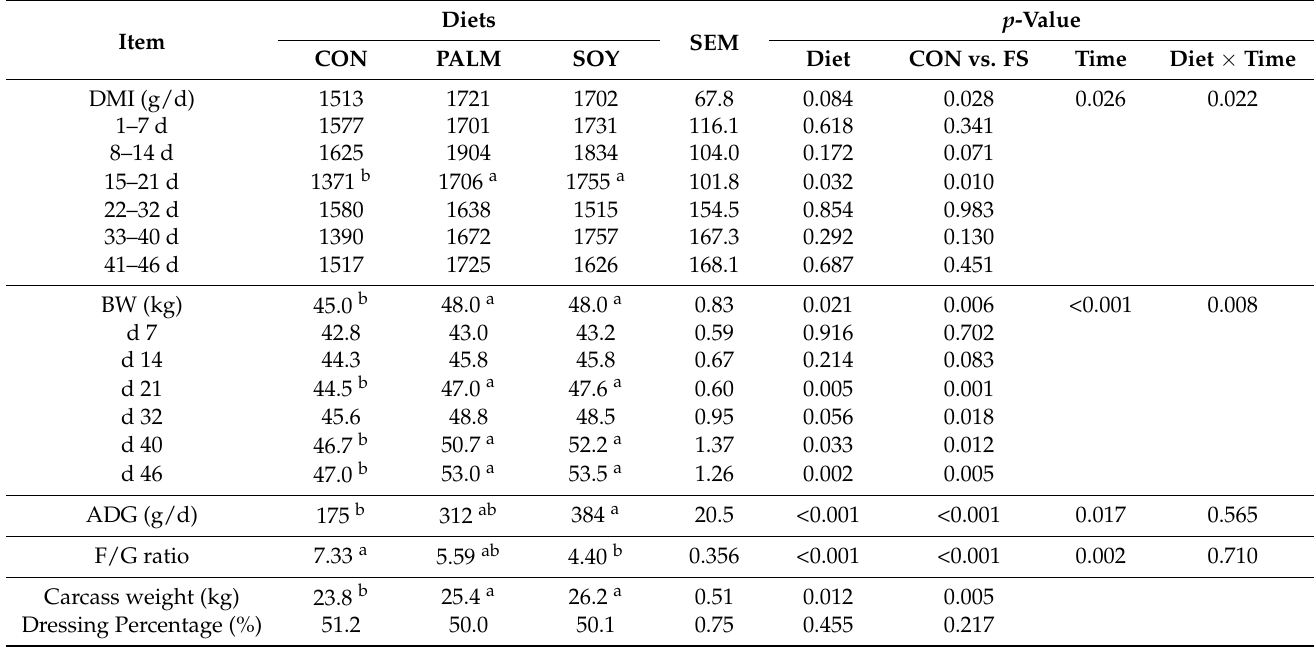
Table 2. Dry matter intake (DMI), average daily gain (ADG), feed to gain (F/G) ratio, and carcass weight responses of lambs fed diets with fat supplements (FS; 50 g/kg) of prilled palm oil (PALM), soybean oil (SOY), or without fat supplementation (CON).